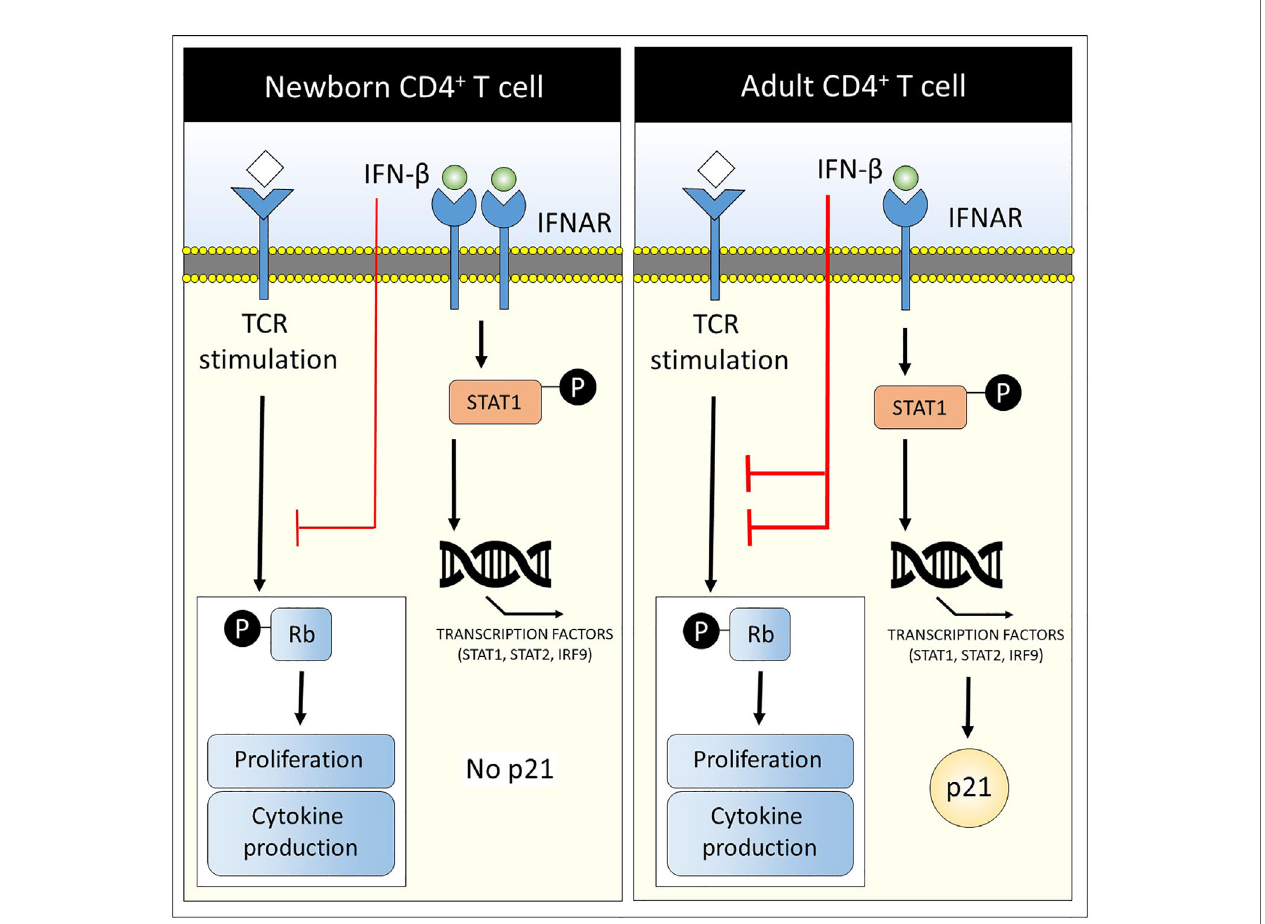
FIGURE 5 | Low CD4 + T cell suppression and lack of cell cycle inhibitor p21 in newborns upon exposure to IFN- b . A graphical abstract is depicted that summarizes the main results of this study: Newborn CD4 + T cells have a distinct pathway of IFN- b -signaling in which (1) newborn CD4 + T cells express higher levels of IFNAR1 and IFNAR2 compared to adults, (2) IFN- b -mediated STAT1 phosphorylation and induction of transcription factors STAT1, STAT2 and IRF9 are comparable between newborn and adult CD4 + T cells but (3) newborn total and naïve CD4 + T cells, contrary to adults, lack the induction of the cell cycle inhibitor p21 after exposure to IFN- b . In addition, IFN- b has a low inhibitory effect on newborn CD4 + T cells with regards to (1) proliferation, (2) phosphorylation of Rb and (3) cytokine production upon TCR stimulation compared to adult CD4 + T cells (red